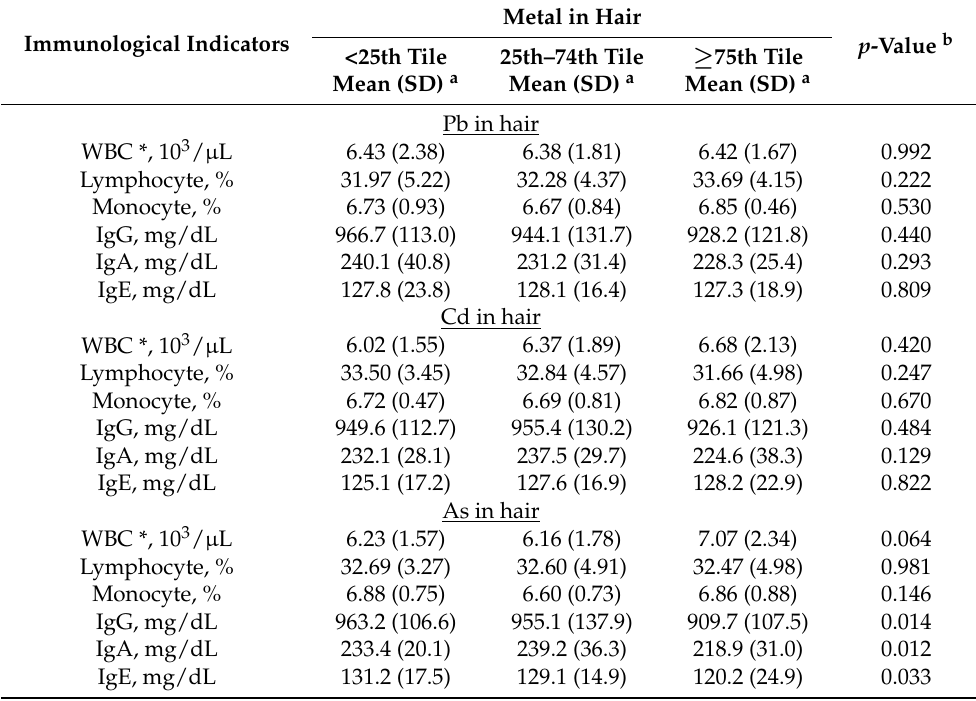
Table 3. Mean levels of immunological indicators by quartile distributions of metals in hair